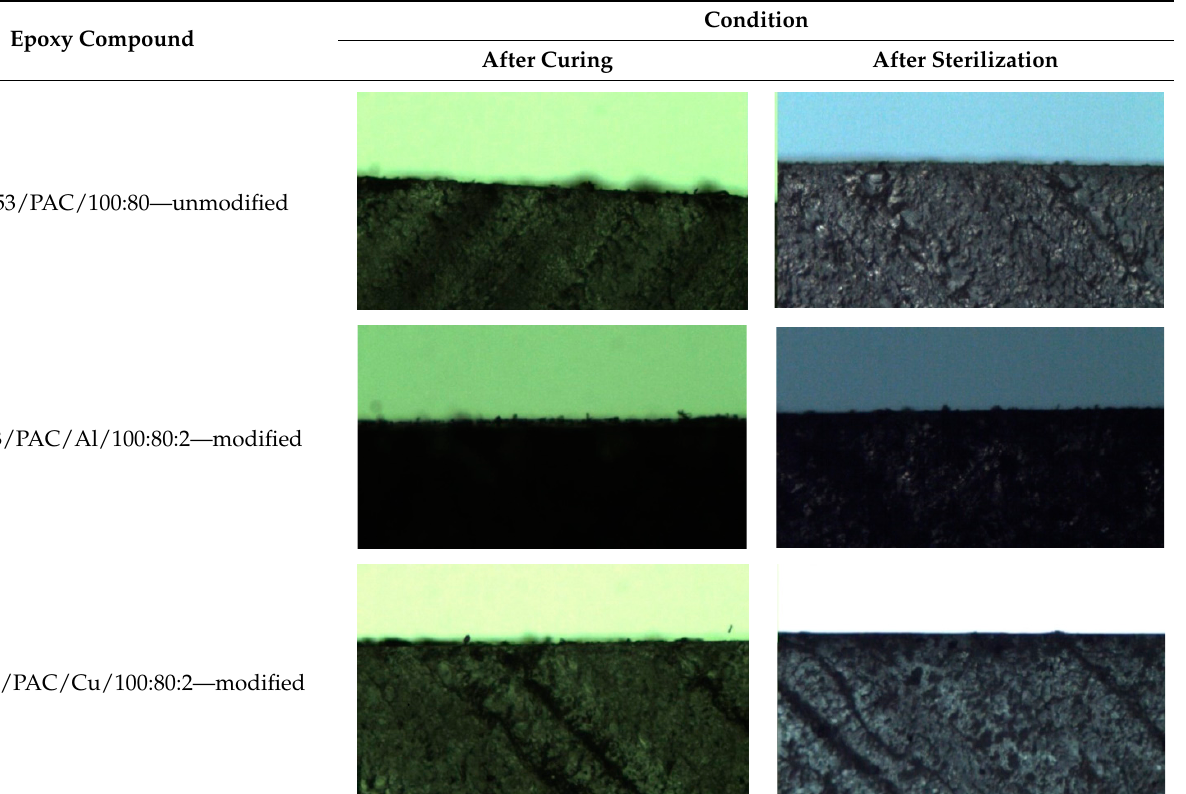
Table 13. Unmodified and filler modified epoxy compounds after curing and after sterilization. Epoxy Compound